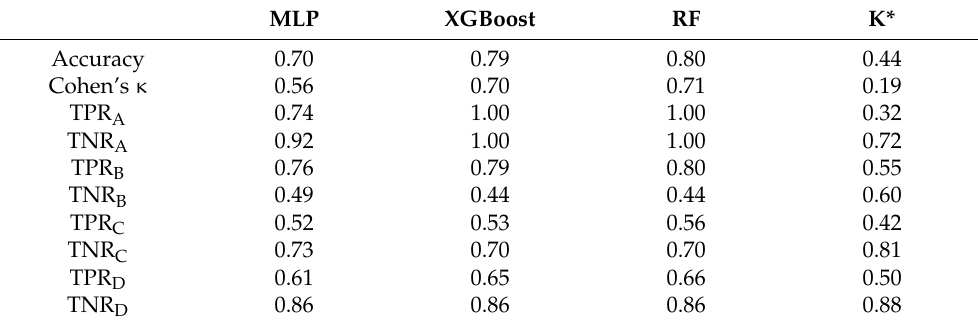
Table 8. The accuracy of predicting the severity of side effects after receiving different COVID-19 vaccines using different ML tools based on the demographic data and other participant